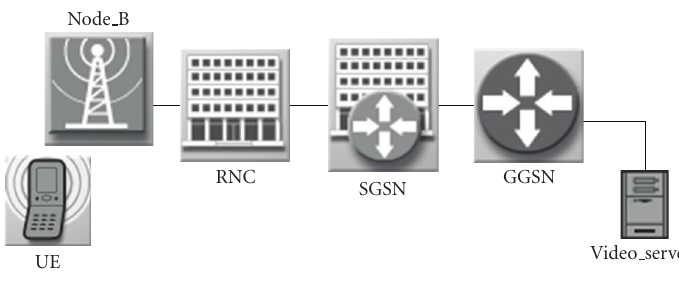
Figure 10: OPNET network